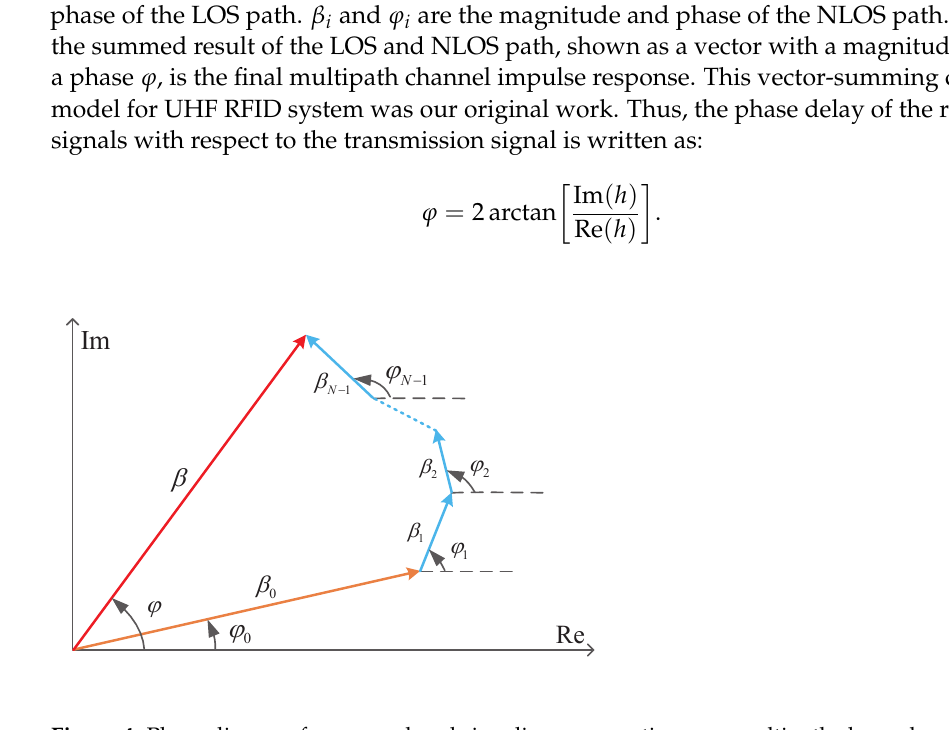
Figure 4. Phase diagram for narrowband signaling propagation on a multipath